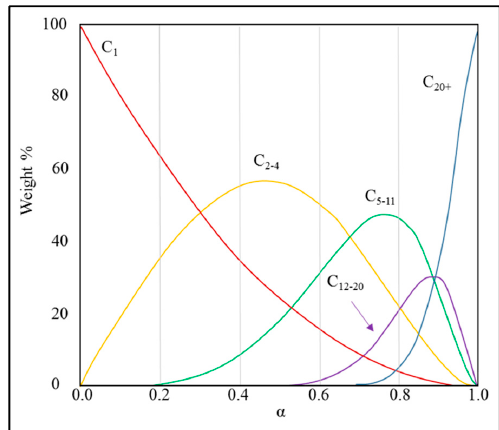
Figure 7. A distribution of products based upon α .